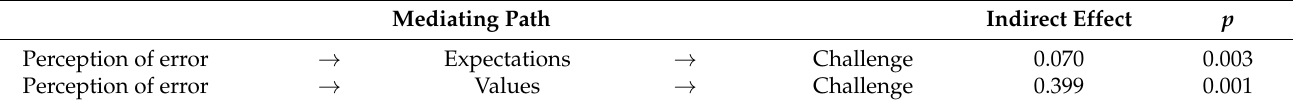
Table 6. Structural equation modeling (SEM) analysis result. Table 7. Individual indirect effect verification results using the Phantom